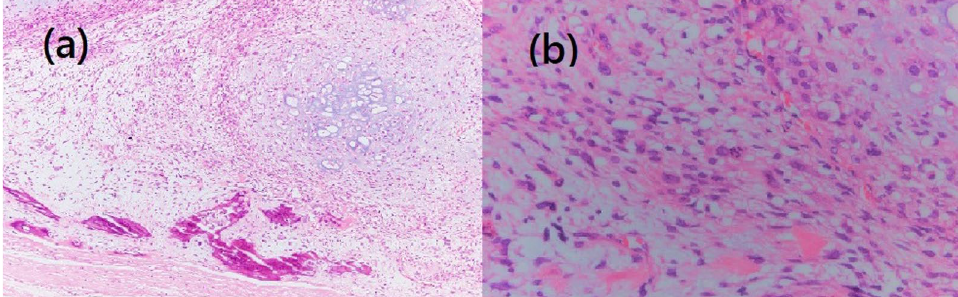
Fig. 3 Histological findings (hematoxylin and eosin staining). Tumor cells are scattered in the myxoid matrix with cartilage differentiation. Ossification is seen at the tumor margin ( a 4). Tumor cells have large and irregular nuclei with hyperchromasia ( b ×